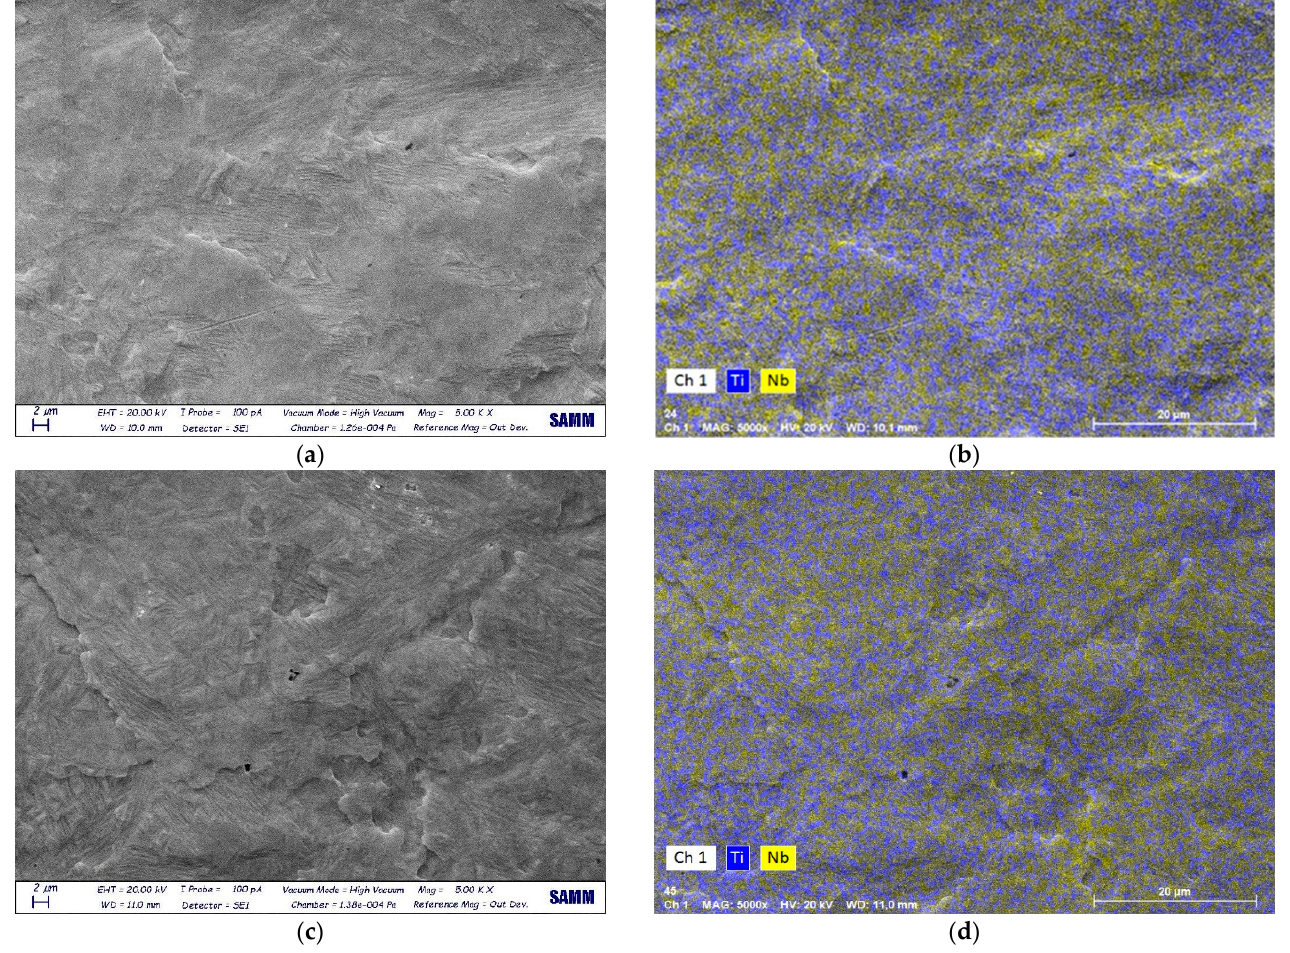
Figure 5. SEM images and EDS maps (Ti, Nb) of sample 16 ( a , b ) and sample 20 ( c , d ), respectively.